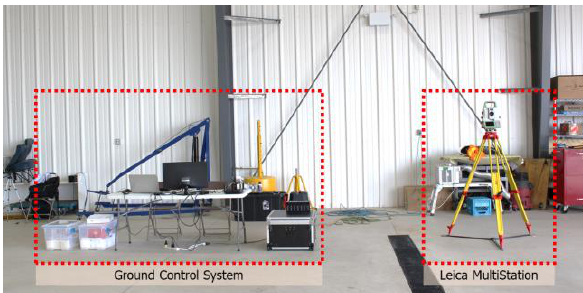
Figure 7. Ground control system and robotic total-station